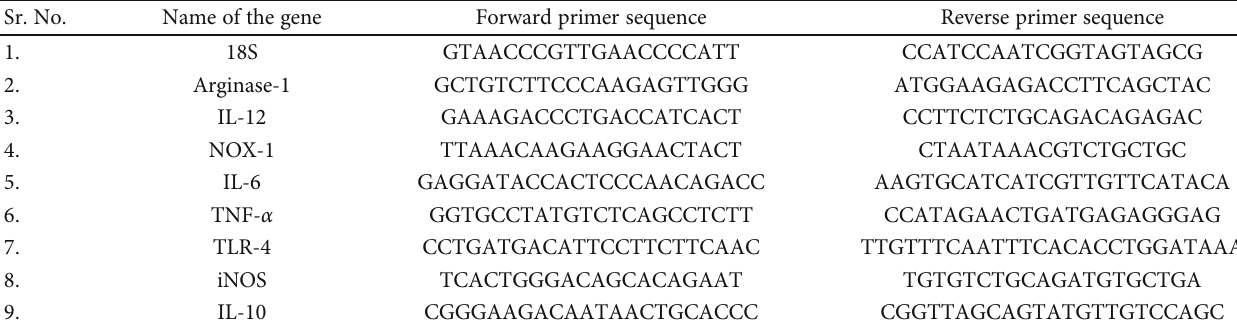
Table 2: The list of Mus musculus primers used for quanti fi cation of mRNA expression levels in qRT-PCR. Sr. No.